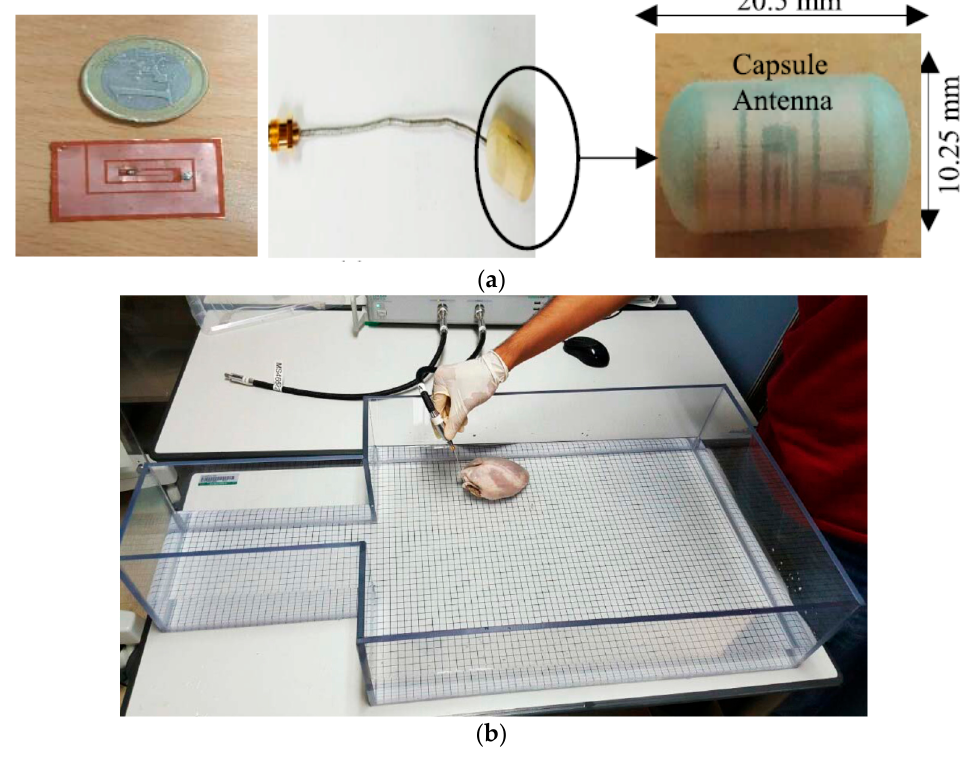
Figure 34. NRRMF WPT system for CE [161]. ( a ) Fabricated conformal antenna and 3D capsule prototype. ( b ) Measurement setup in ASTM phantom. Copyright © 2017, IEEE.